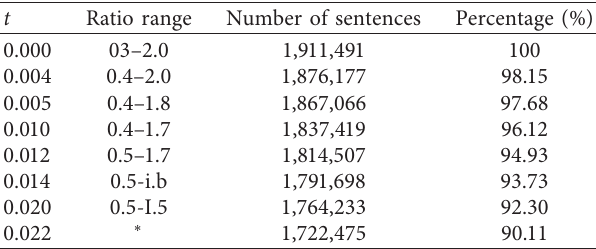
Table 5: Scores of 8 length ratios on the development set after